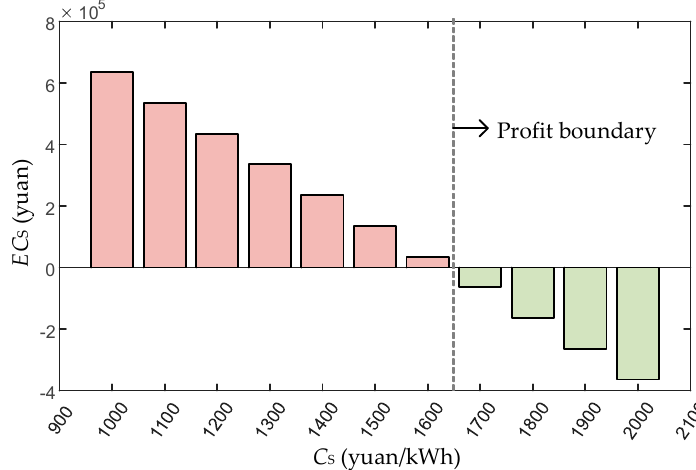
Figure 7. EC S values with different unit prices of initial investment.